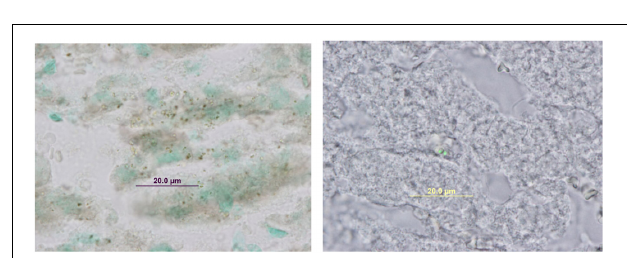
FIGURE 3 | Immunohistochemical staining with anti-GFP in maternal liver infected with Staphylococcus aureus SH1000